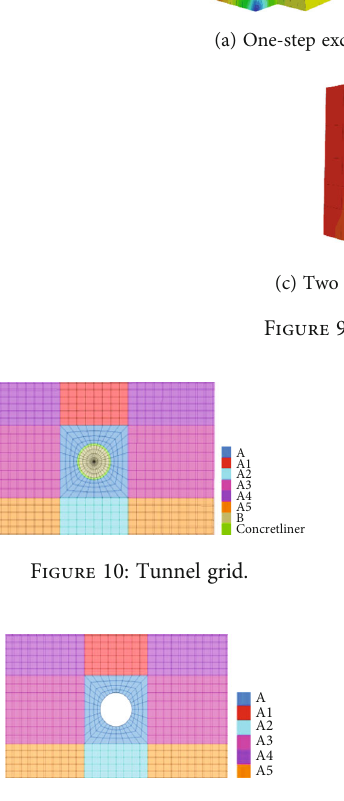
Figure 11: Model diagram after